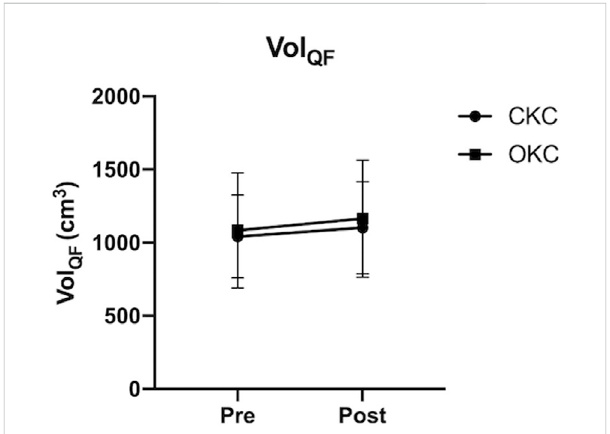
FIGURE 2 Group average ( n = 12) changes in quadriceps femoris volume (VOL QF ) in response to 8 weeks of open (OKC) and closed-kinetic chain (CKC) exercise. Mean and standard deviation are reported. *signi fi cant differences ( p ≤ 0.05) between interventions over time (interaction effect). # signi fi cant difference within conditions over